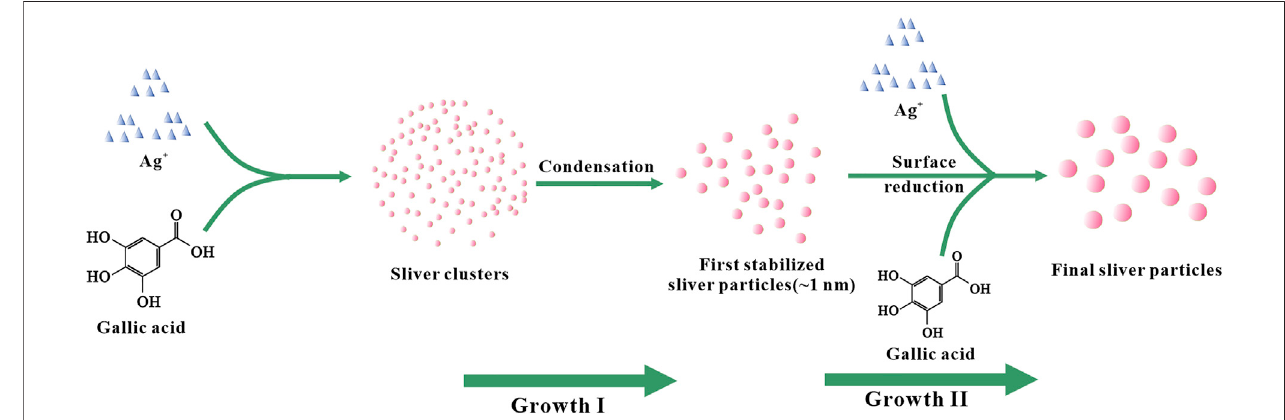
FIGURE 4 | Schematic diagram of the growth of